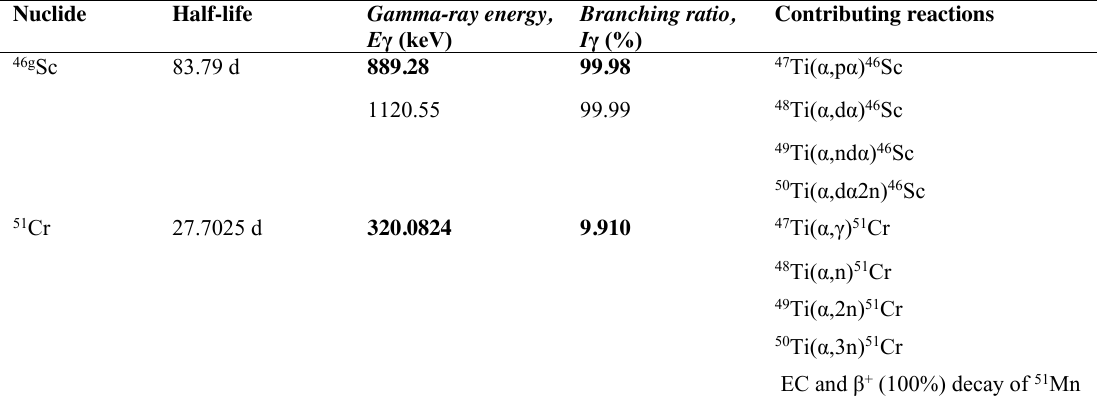
TABLE 1 : Decay data of the radioisotopes adopted in this study as evaluated decay data in the ENSDF library [19, 20] extracted from the interface of Live Chart of nuclides [21] while Q-values [22] were extracted from Qtool system [23]. Nuclide Half-life Gamma-ray energy, Branching E γ (keV)